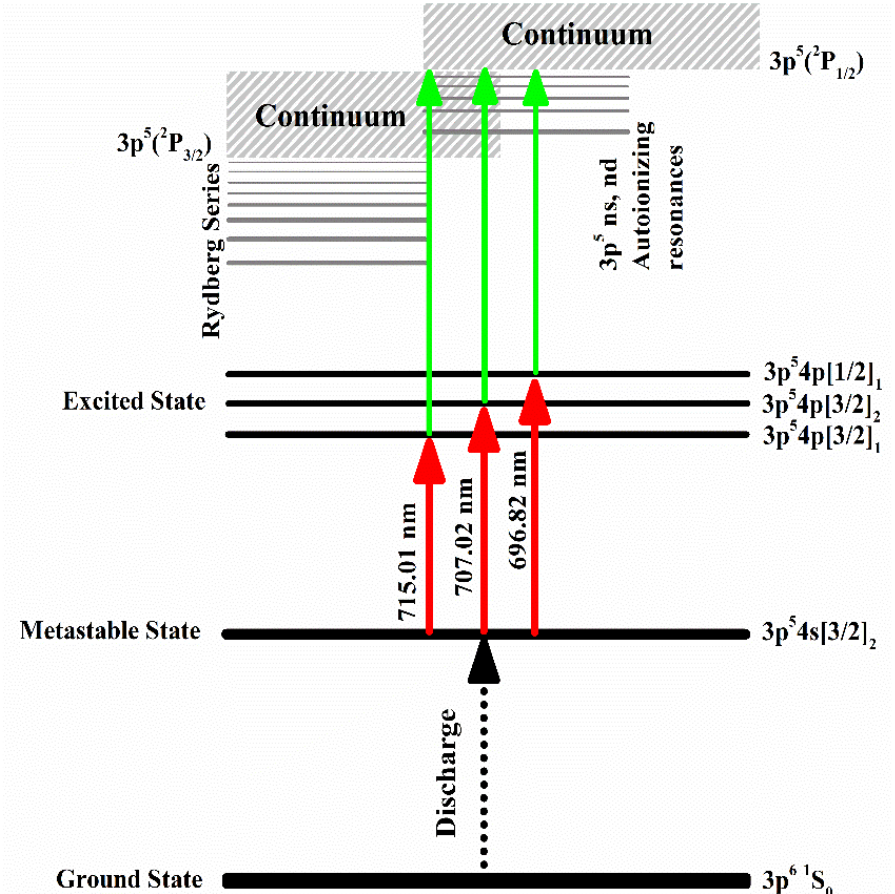
Figure 12. Excitation scheme to access the above threshold photoionization in argon.